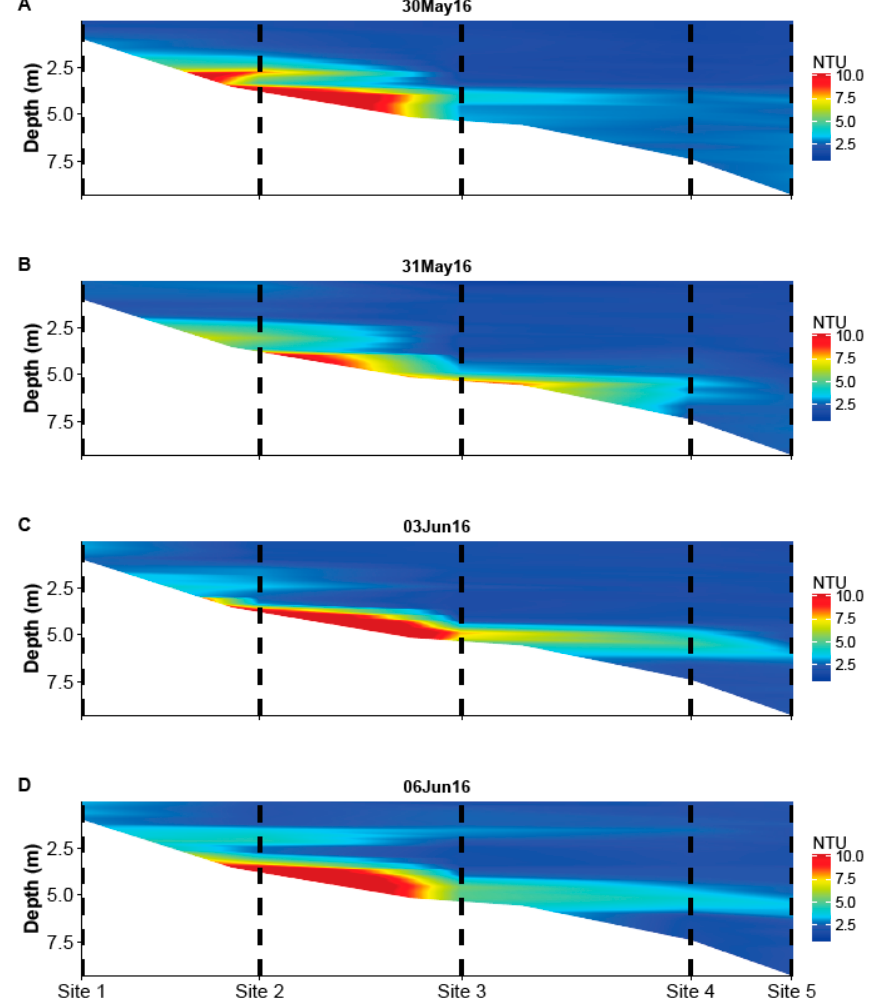
Figure 9. ( A – D ) Turbidity across a longitudinal cross-section in Falling Creek Reservoir (FCR) from ( A ) immediately before EM1 (30 May), ( B ) 24 h after EM1 (31 May), ( C ) 4 days after EM1 (03 June), and ( D ) one week after EM1 (6 June). Contours are interpolated from CTD casts taken at the upstream and deepest sites (denoted by the vertical lines; upstream sampling sites are shown on the inset in Figure 1).